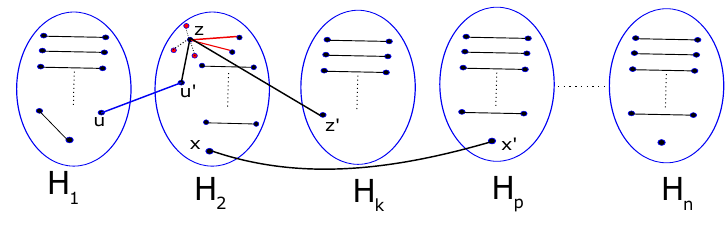
Figure 3: Case 2.2.1: | F V